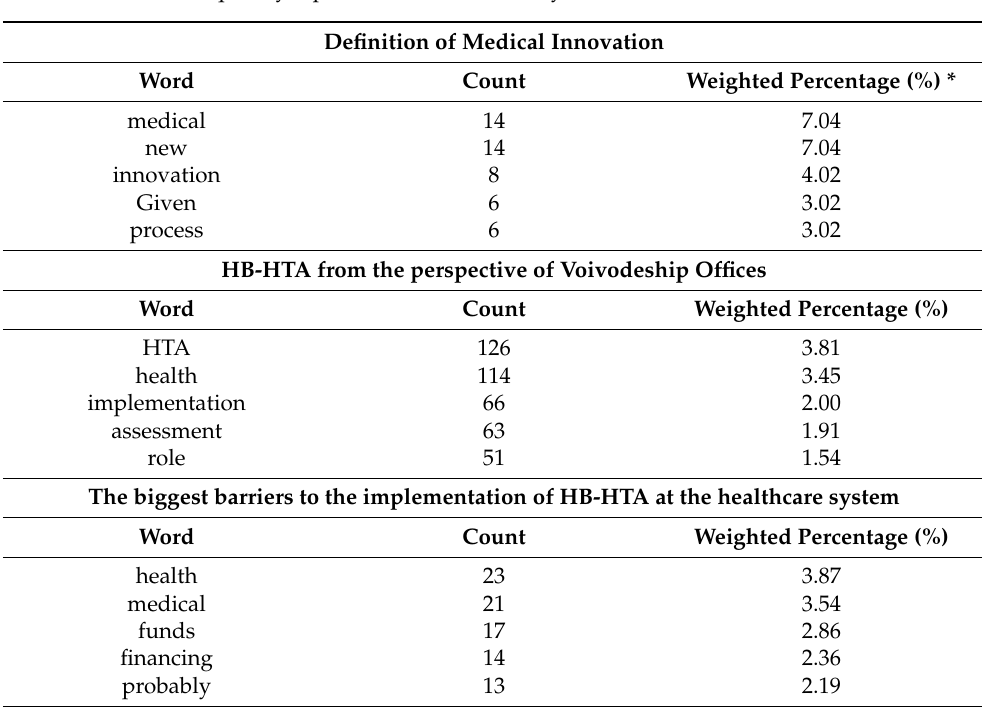
Table 2. The most frequently repeated words in all analyzed